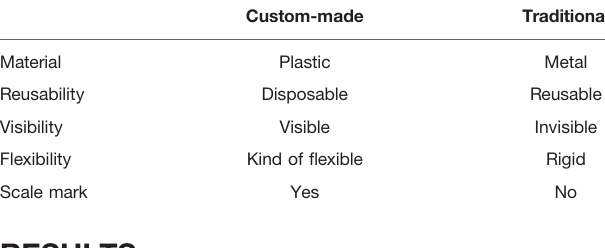
TABLE 1 | Differences between the custom-made and traditional working channels.